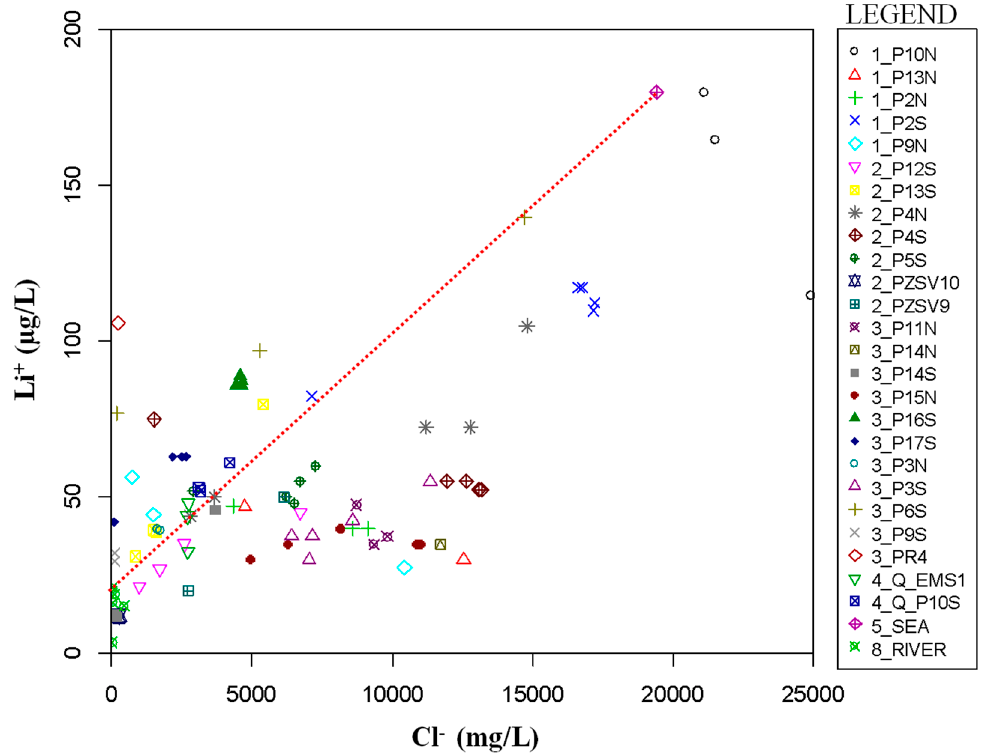
Figure 9. Scatterplot Li + vs. Cl − of all groundwater samples. Red dotted line indicates conservative mixing between rivers and sea used as end members.